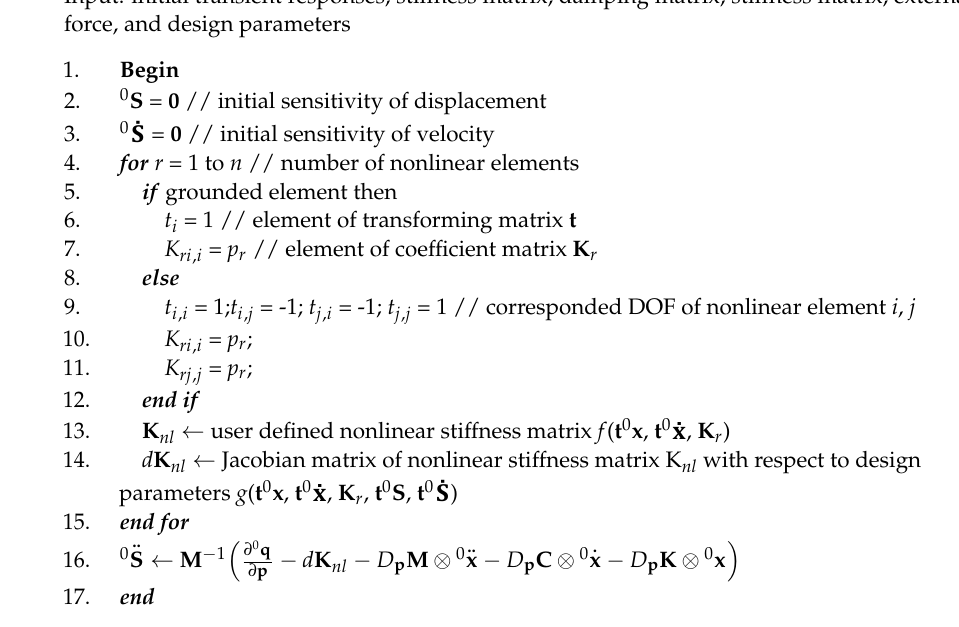
Algorithm 1. Pseudo-code for initial transient response sensitivity